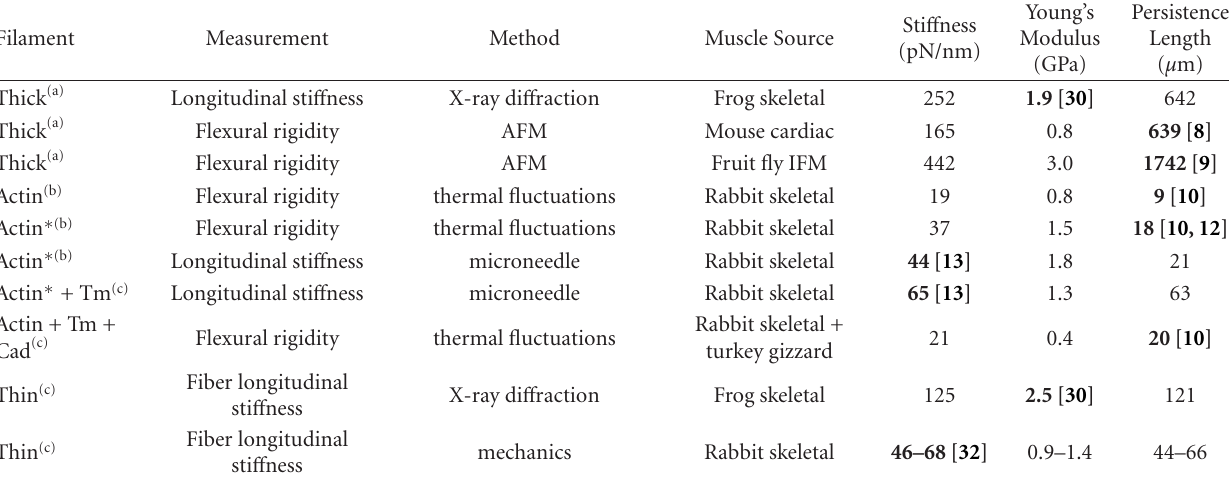
Table 1: Mechanical properties of thick filaments and thin